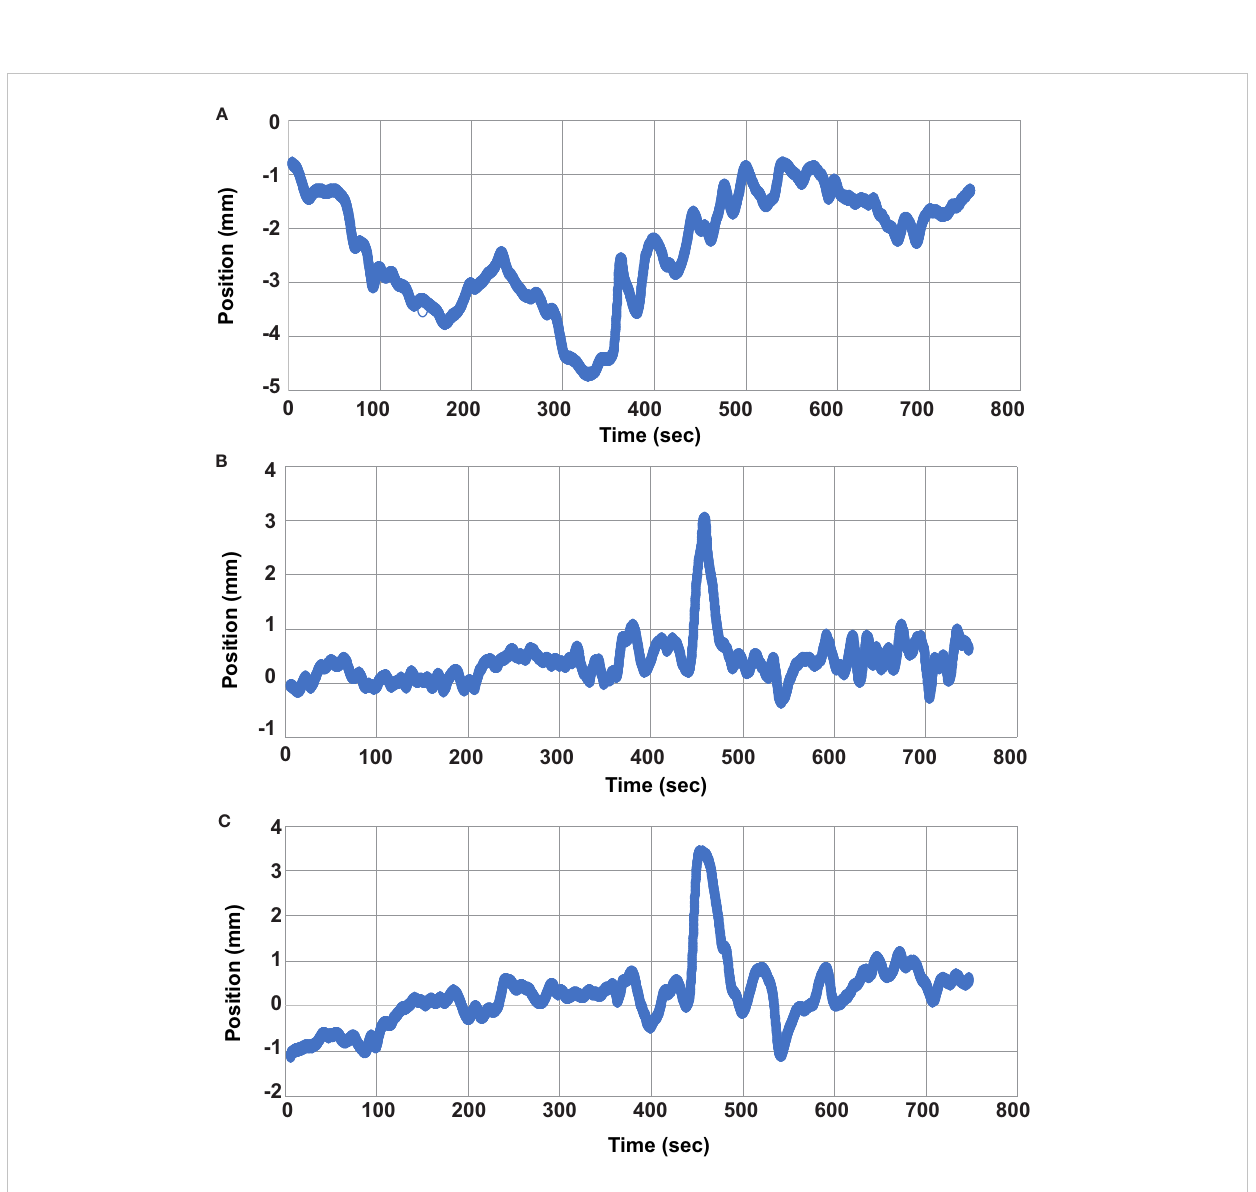
FIGURE 5 Individual Fraction Motion Trace. Individual motion trace for second treatment fraction of patient 7. (A) left/right direction, (B) anterior/posterior direction, and (C) superior/inferior